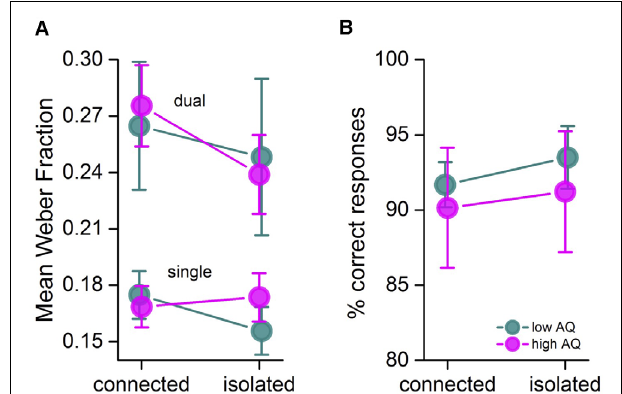
FIGURE 4 | (A) Mean Weber fraction for discriminating numerosity in the isolated and connected conditions for the two groups and the two tasks. (B) Mean correct responses to the central visual distractor for the connected and isolated condition in the two groups. Color-coded as in Figure 3 . Error bars = ± 1